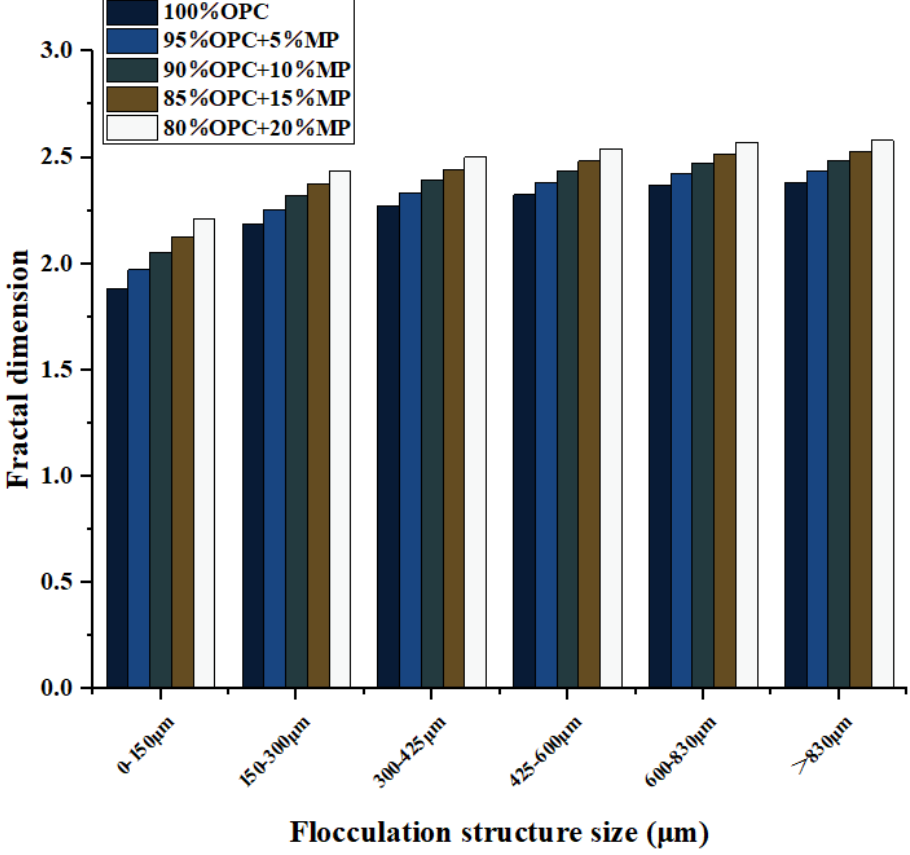
Figure 10. Differentiation of fractal dimension with W/CM ratios at different MP contents.